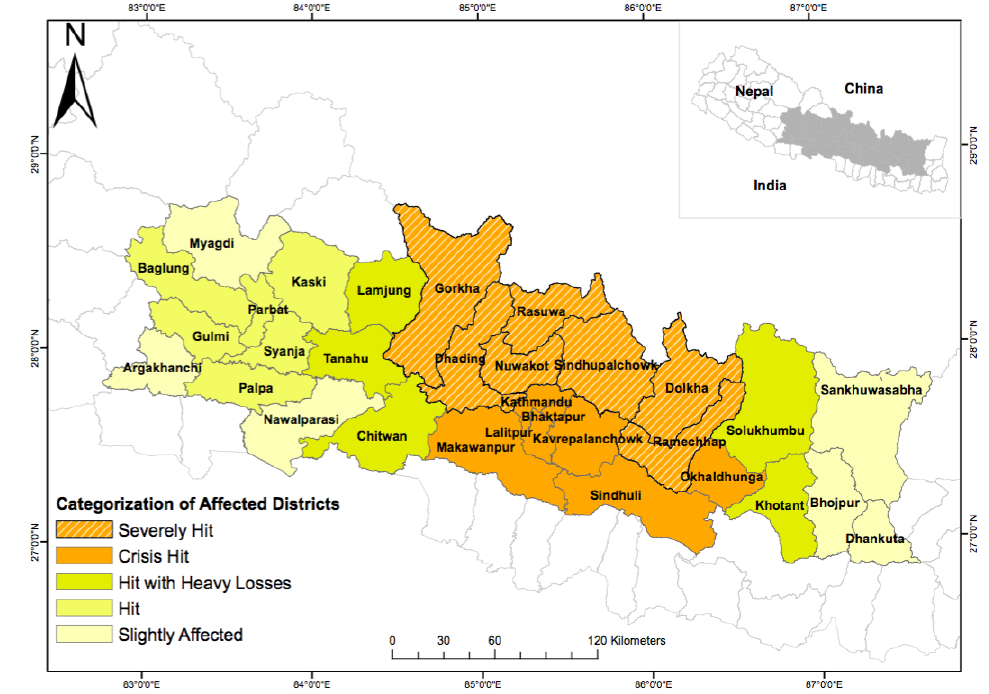
Figure 1. Prioritization of affected districts (Source: GoN NPC (2015) PDNA Report).